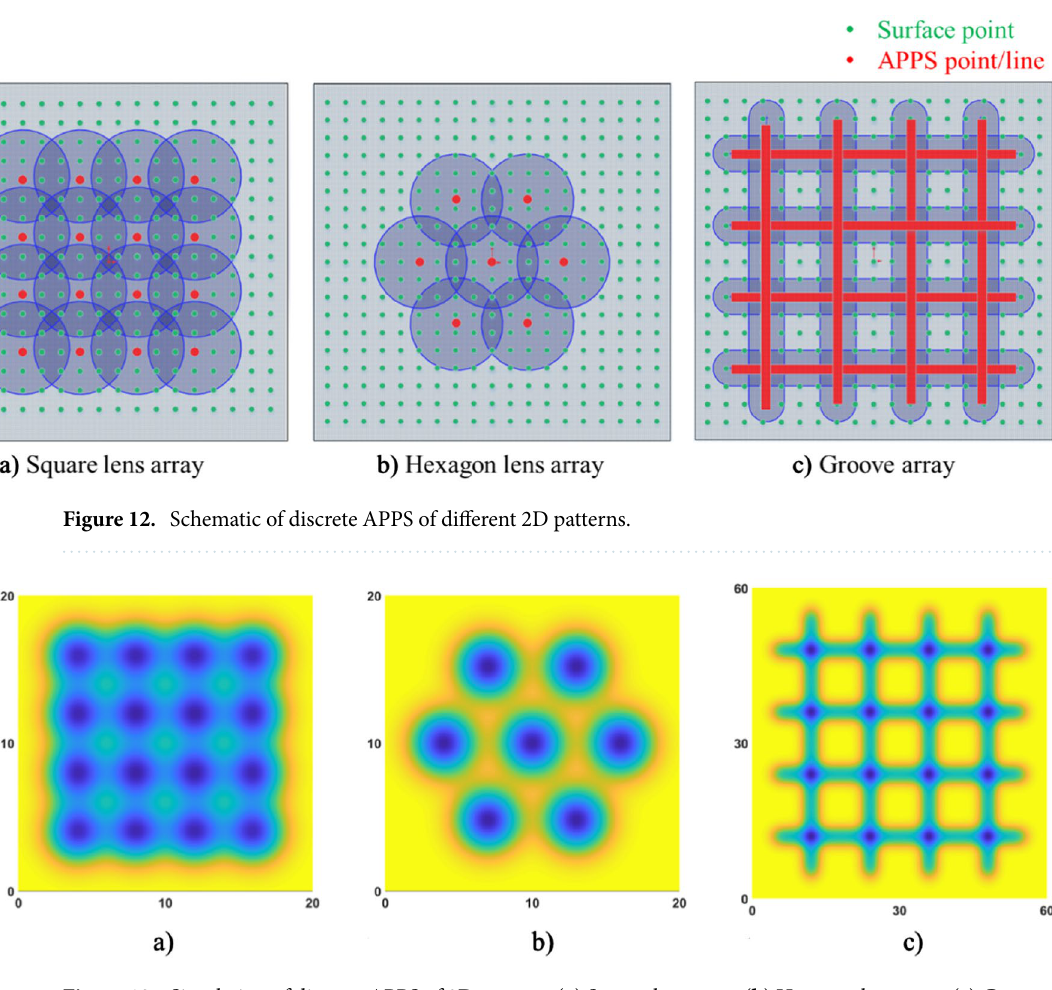
Figure 13. Simulation of discrete APPS of 2D patterns ( a ) Square lens array ( b ) Hexagon lens array ( c ) Groove